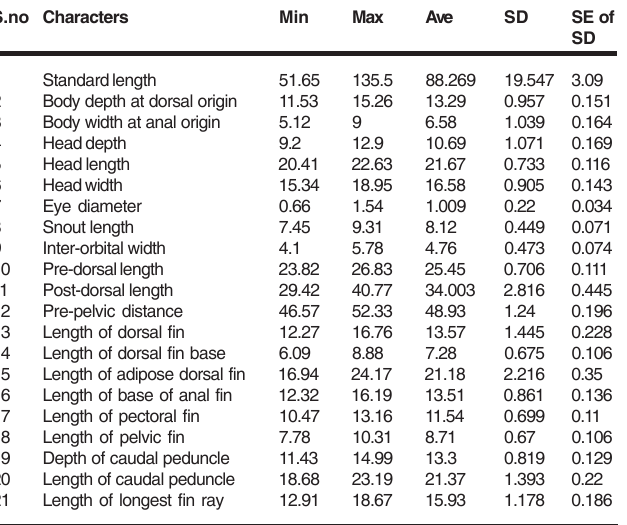
Table 4. Morphometric characters of male in % SL except SL given in mm S.no Characters